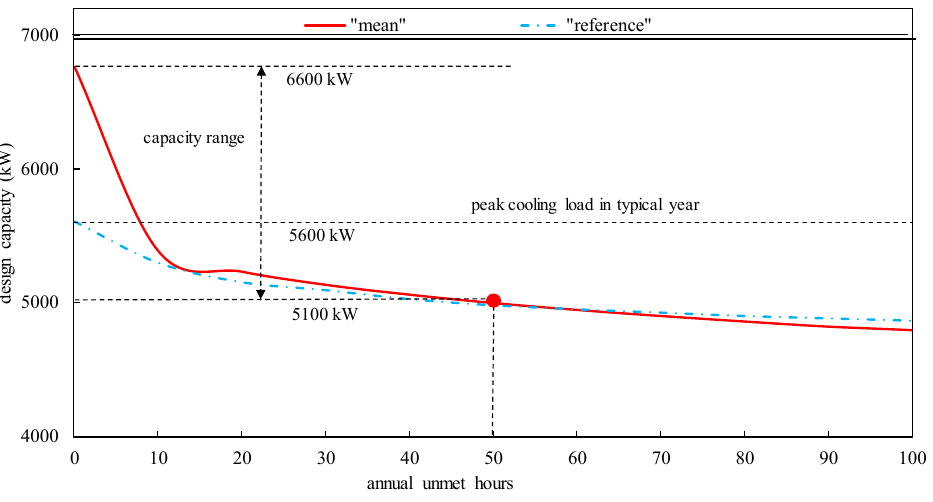
Figure 9. Cooling capacities vs. number of annual unmet hours.